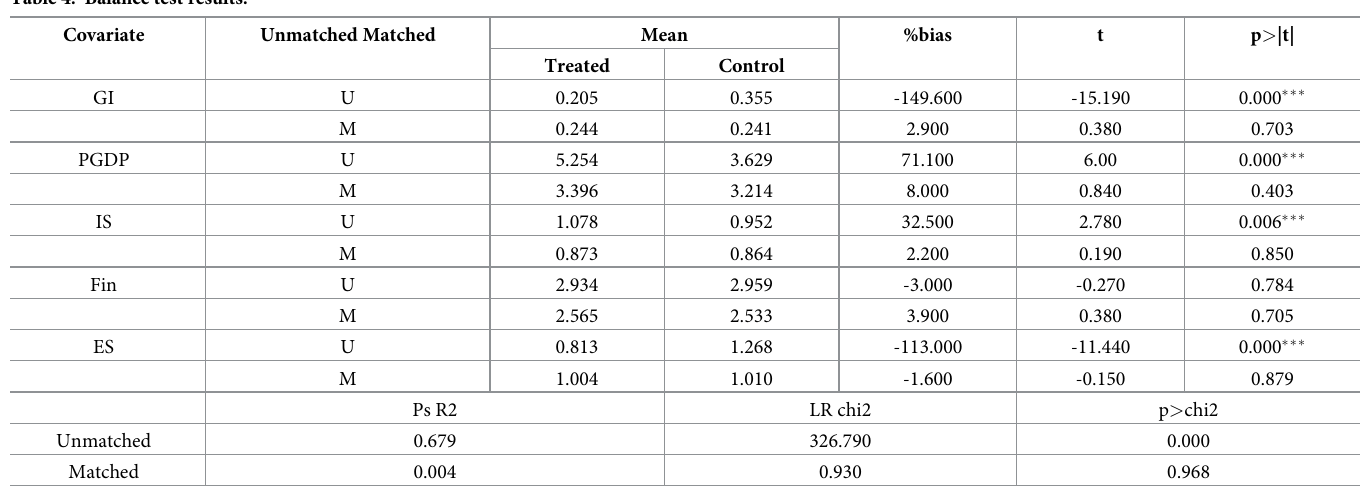
Table 4. Balance test